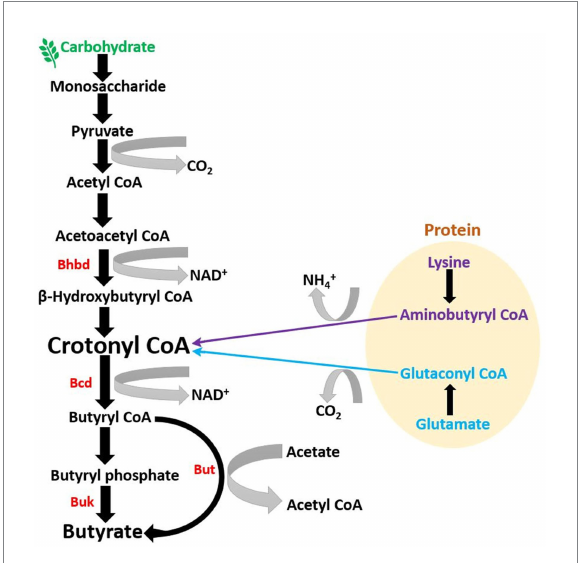
FIGURE 1 Microbial pathway to generate butyrate in gut: Majority of butyrate in the colon is generated by the metabolization of dietary fibers, primarily of carbohydrate origin (BHBD, β -hydroxybutyryl-CoA dehydrogenase; Bcd, butyryl-CoA dehydrogenase; But, butyryl-CoA: acetate CoA-transferase; Buk, butyrate